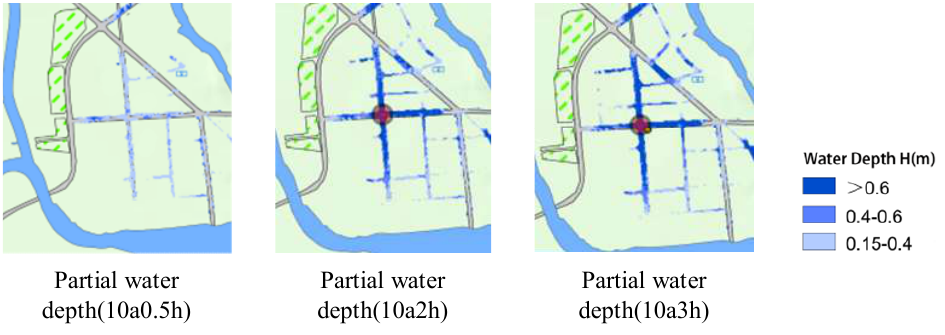
Figure 7. Water depth map for 1 in 10-year rainfall.